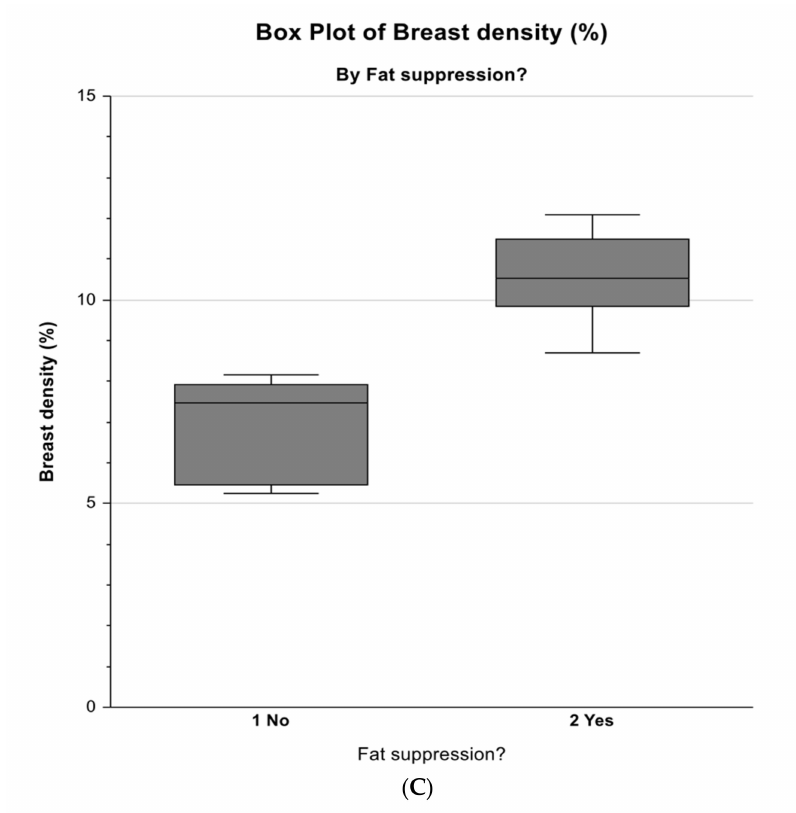
Figure 3. Box plots demonstrate the distribution and median of three main parameters: ( A ) breast volume, ( B ) fibroglandular tissue volume, and ( C ) percentage of breast density measured on the non-fat-suppressed and the fat-suppressed MRI sequences. The six MRI sequences compartments were re-configured into a two-way cross-classification, namely two fat-suppression categories. As shown, “1 / No” is the non-fat-suppression, “2 / Yes” is the fat-suppression, which are on the x -axis, while the three parameters measured with respect to these two corresponding categories are on the y